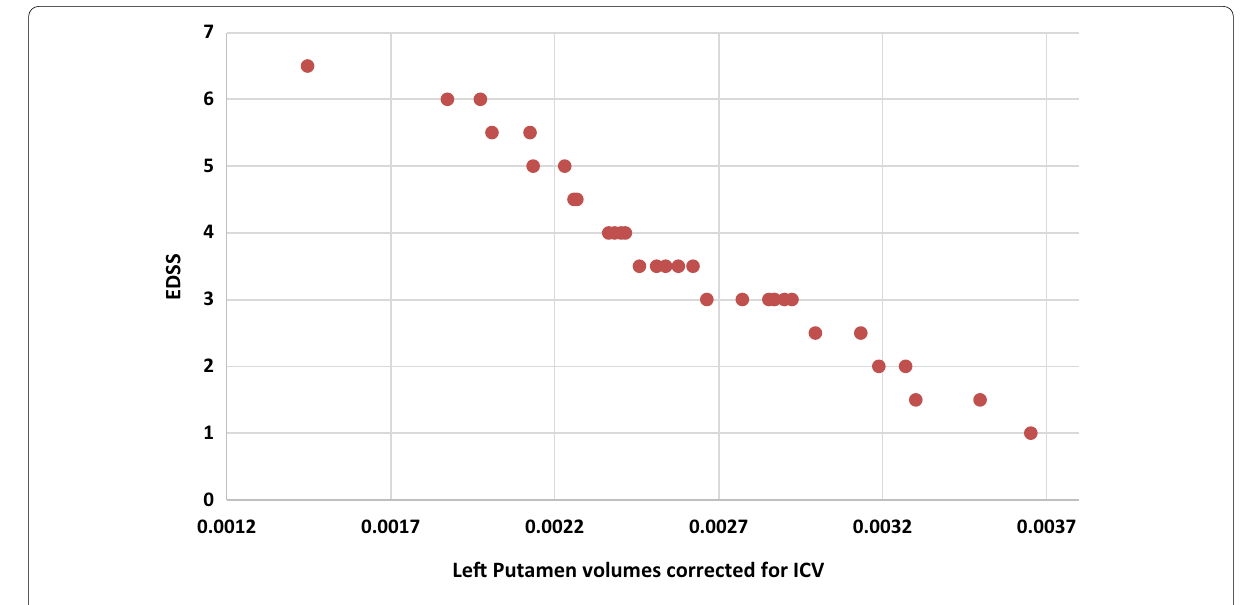
Le(cid:17) Putamen volumes corrected for ICV